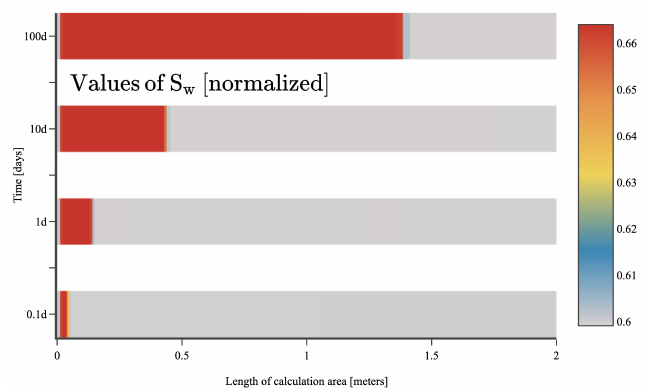
Figure 6. Water saturation profile S w in the area of the fault for the time moments t = 0.1, 1, 10, 100 days. X-axis: calculation length in horizontal direction of the reservoir is taken close to the fault (up to 2 m), where 0 X-value represents the